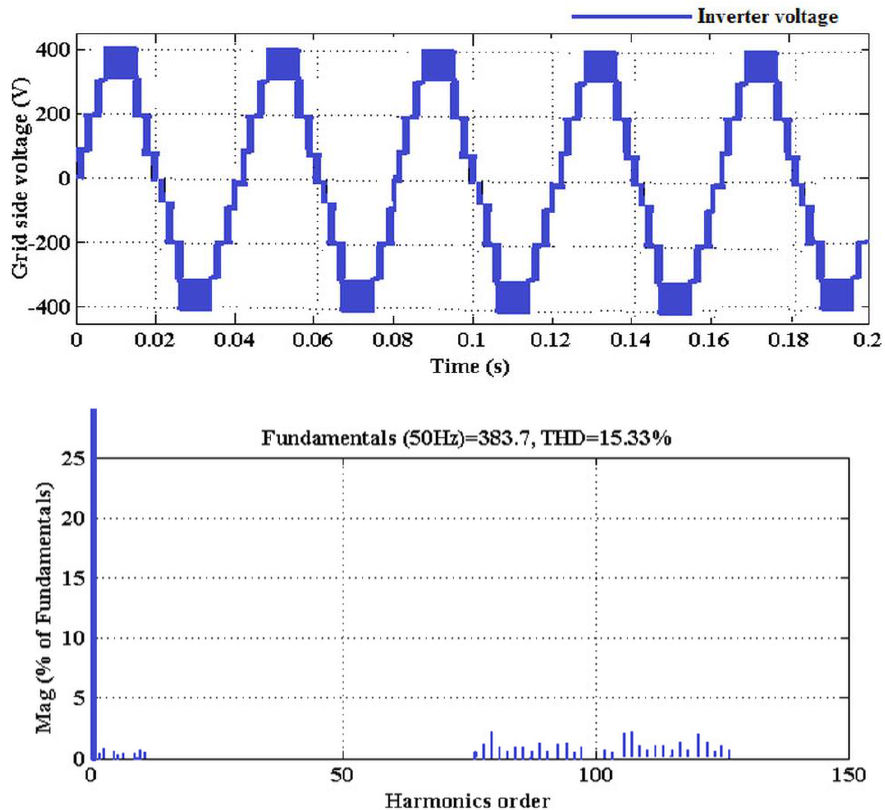
Figure 15. Grid voltage and its harmonics spectrum.